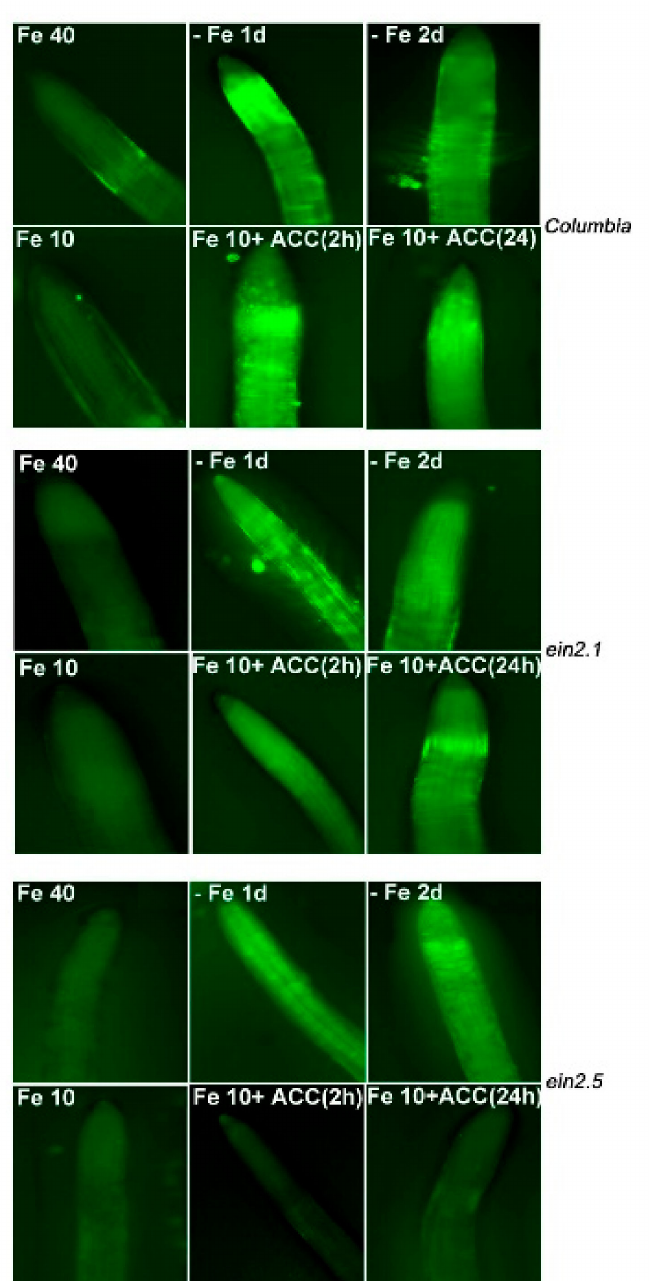
Figure 6. Effect of Fe deficiency and ACC on nitric oxide (NO) accumulation by roots of Arabidopsis wild-type Columbia and the ET insensitive mutants ein2-1 and ein2-5 . Plants were grown in complete nutrient solution. When appropriate, some of them were transferred to complete nutrient solution with 40 µ M Fe-EDDHA (Fe40), with 10 µ M Fe-EDDHA (Fe10) or without Fe, either during 1 day (–Fe 1d) or 2 days (–Fe 2d). ACC, at 1 µ M final concentration, was added to some of the plants in the Fe10 treatment during either 2 h [Fe10+ACC (2 h)] or 24 h [Fe10 + ACC (24 h)]. NO was visualized with the NO-sensitive fluorescent dye DAF-2 DA. Notice the localization of NO accumulation, induced by either ACC treatment or Fe deficiency, on the subapical region of the